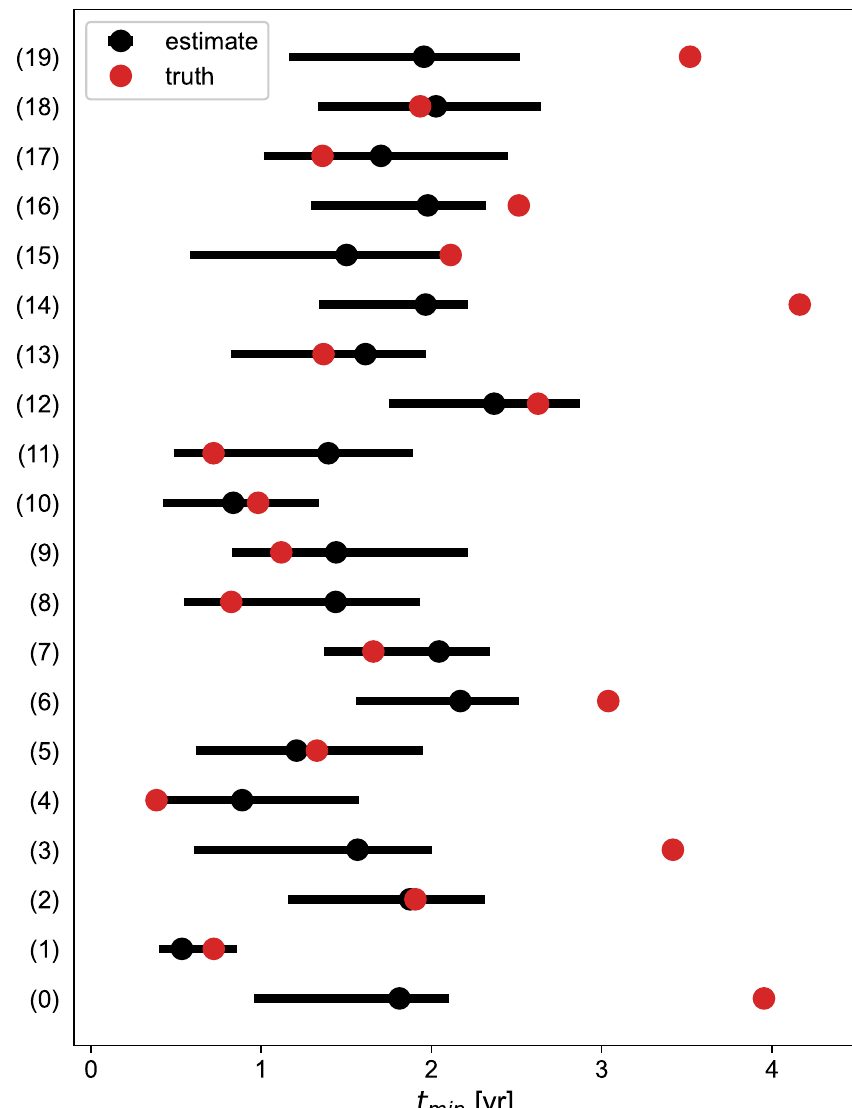
Fig 7. Performances of the regrowth time estimates with 3 measurements at t mes = [ − 6, 0, 3] months for a set of true parameters corresponding to the bestfits of our 20 patients. Black points represent the mean of the estimates and the bars the 95% confidence-level interval. The red point is the true value associated to each best-fit for the patients labeled on the vertical axis (corresponding to the dashed lines in Fig 2). Note that only the best-fit parameters of each patient are being used